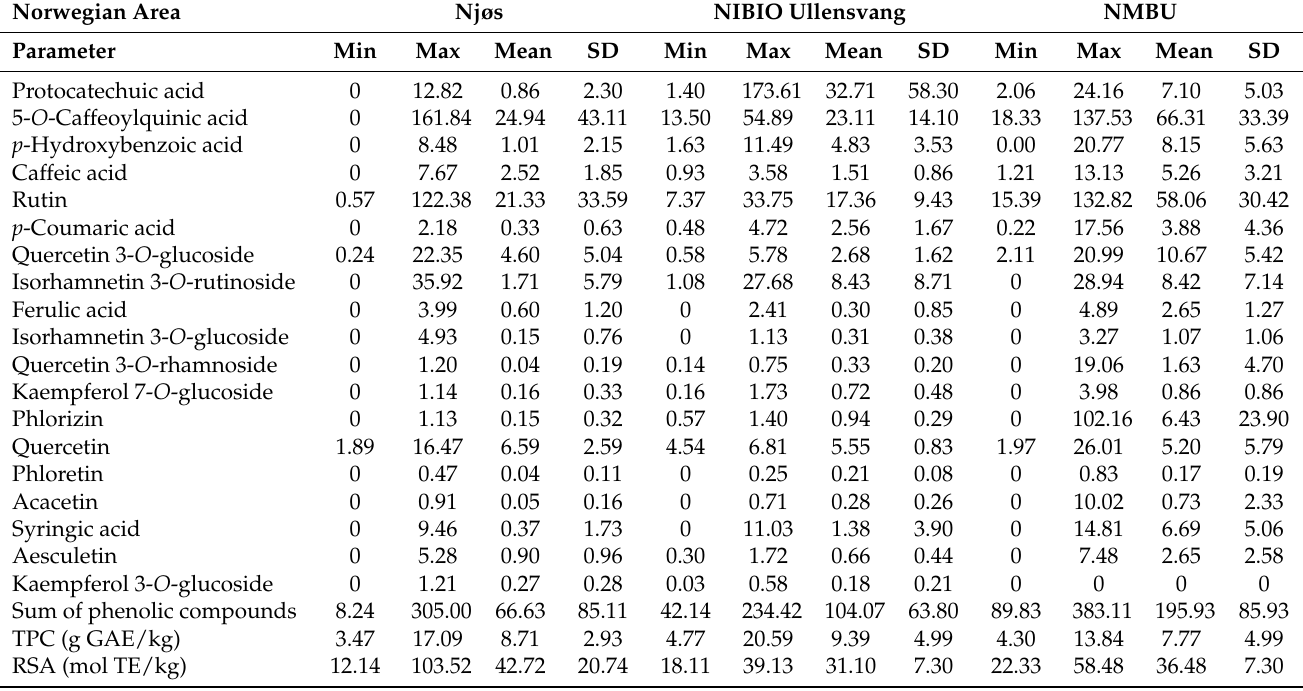
Table 5. Descriptive analysis of the content of phenolic compounds (mg/kg), total phenolic content (TPC, g GAE/kg dw), and relative scavenging activity (RSA, mmol TE/kg dw) in 68 Norwegian plum cultivars from Njøs (42 samples) and NIBIO Ullensvang (8 samples) collected in 2019 and